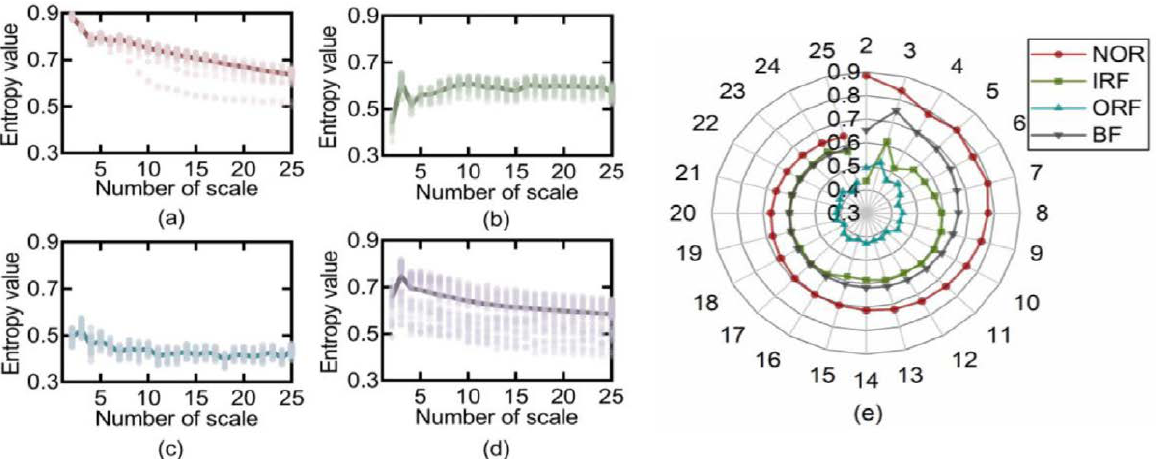
Figure 50. CMWPE entropy curves to diagnose ( a ) normal, ( b ) inner raceway, ( c ) outer raceway, ( d ) ball bearing faults, and ( e ) mean values for all states of fault faults. Reproduced with permission of [126].